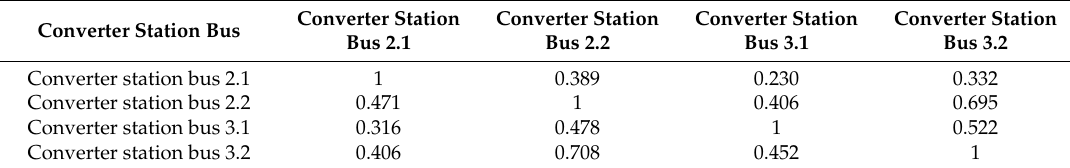
Table A5. The MIIF of converter station buses with Area 4 to be isolated.